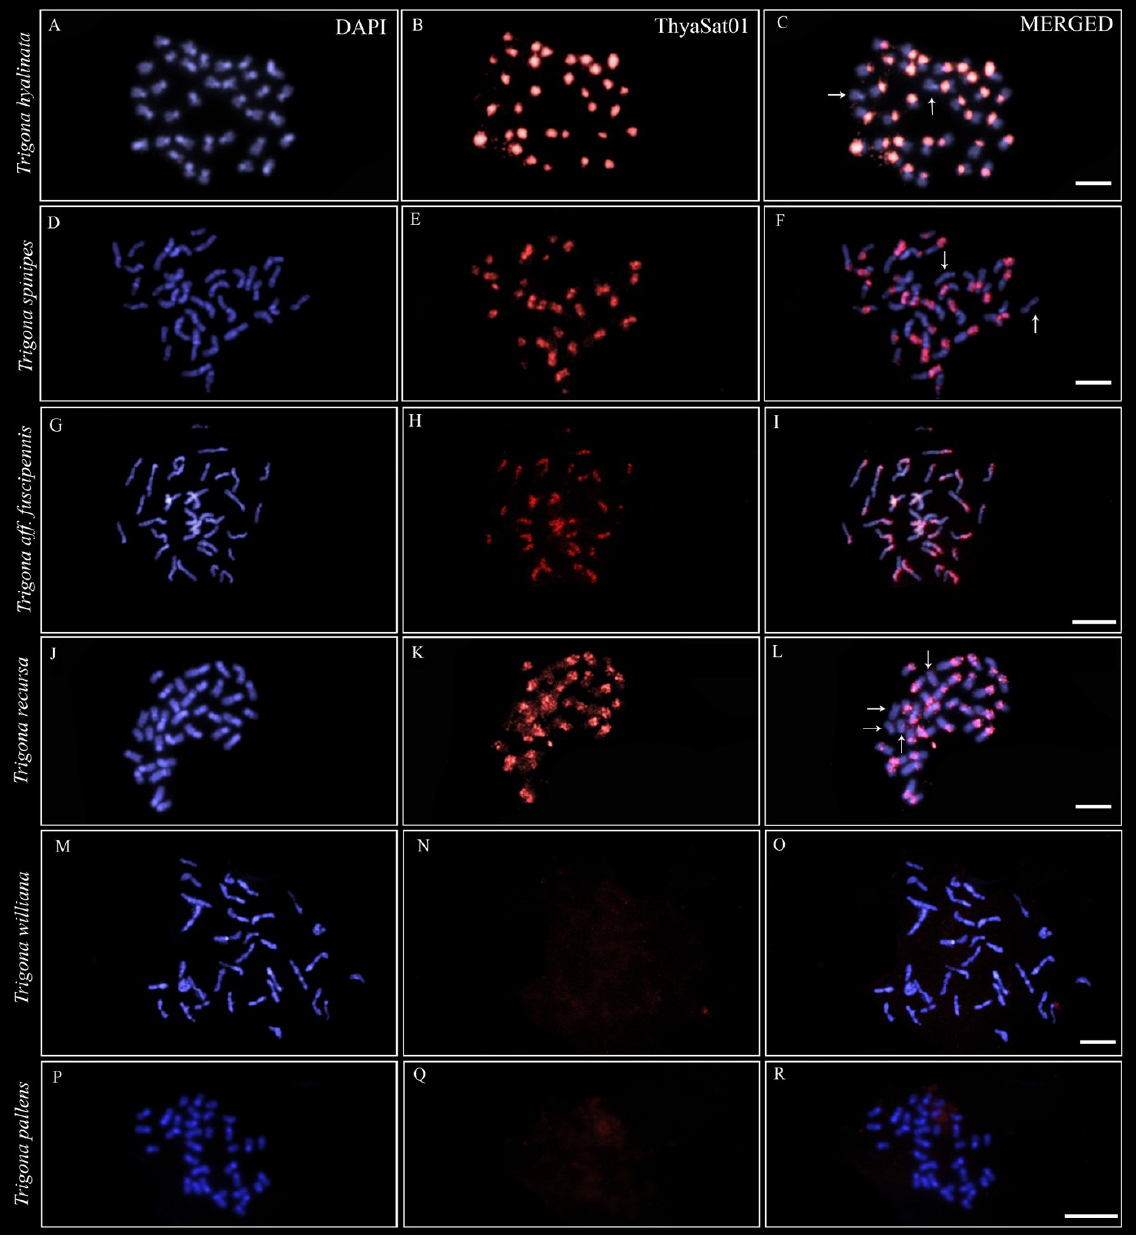
Figure 3. Chromosomal distribution of ThyaSat01-301 detected by FISH in Trigona . ( A – C ) T. hyalinata ; ( D – F ) Trigona spinipes ; ( G – I ) Trigona aff . fuscipennis ; ( J – L ) Trigona recursa; ( M – O ) Trigona williana ; ( P – R ) Trigona pallens . ( A – L ) Clade B representatives, ( M – R ) clade A representatives. Blue corresponds to chromosomes stained with DAPI and red corresponds to FISH signals. The arrows correspond to the chromosomes where no FISH signals were observed. Note differences in the intensity of hybridization signals between species, with occurrence of scattered signals for Trigona fuscipennis and Trigona recursa . Bar = 5 μ m.